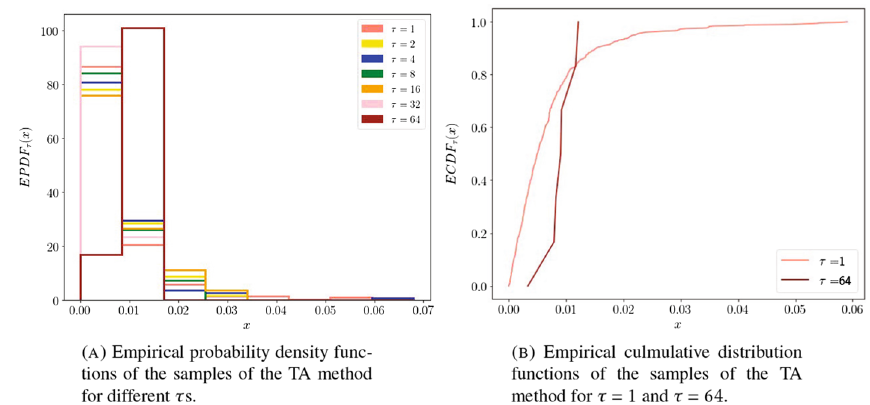
Fig. 6 Distributions of the samples of the TA